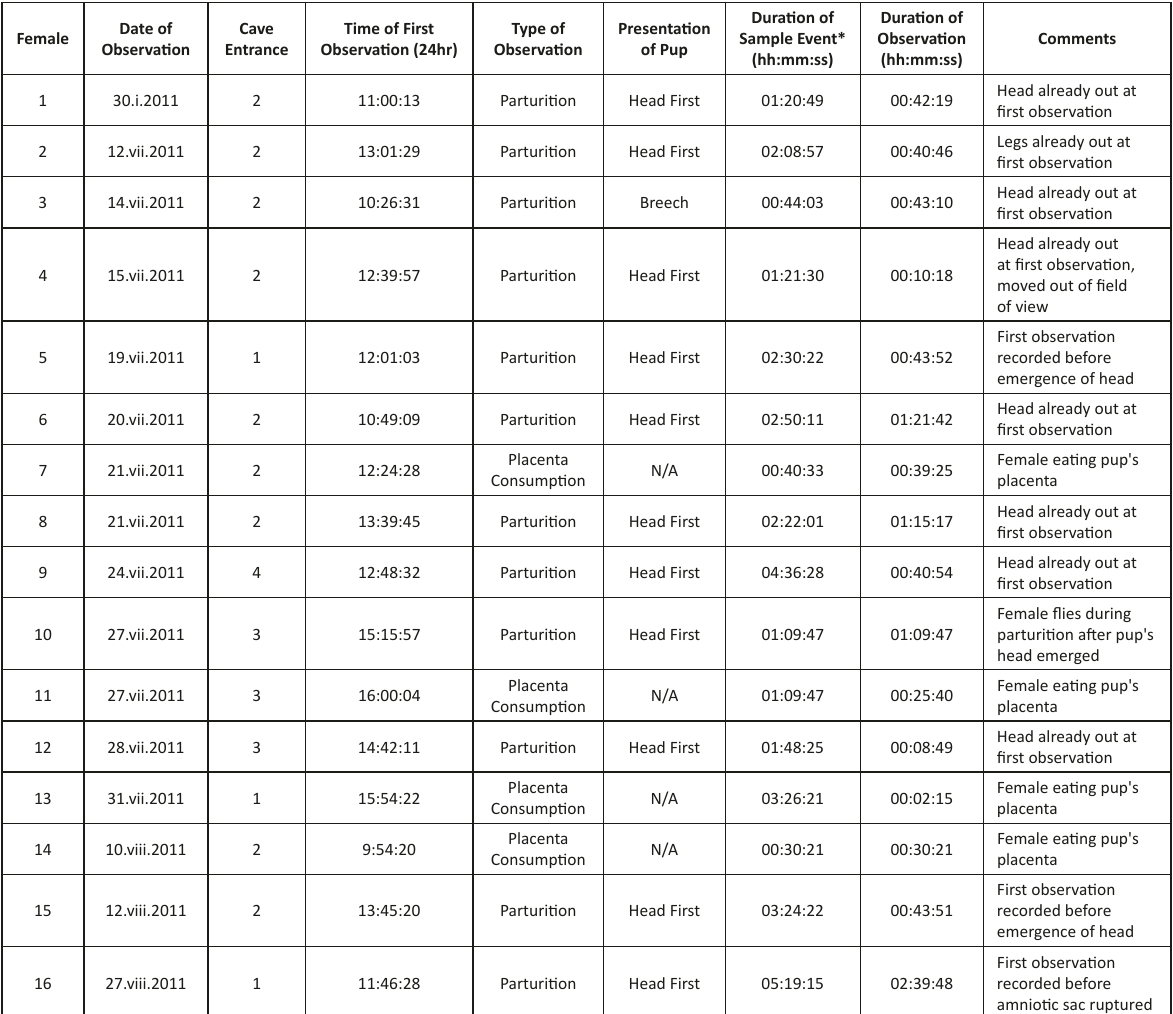
Table 1. Quantified observations for the 16 pregnant R. amplexicaudatus sampled in this study. *Total length of continuous video sampling in which birthing event was observed. Date of Cave Female Observation